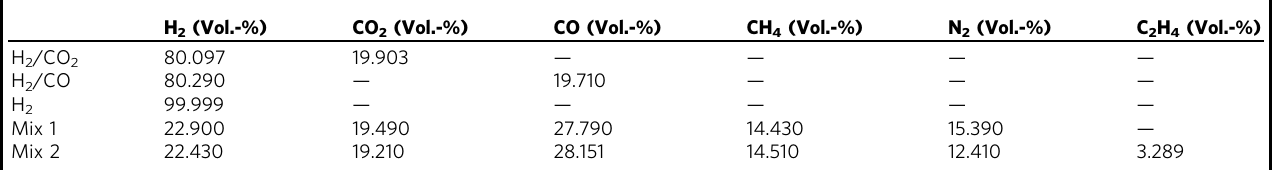
Table 2 Composition of the different test gases for the low-pressure experiments H 2